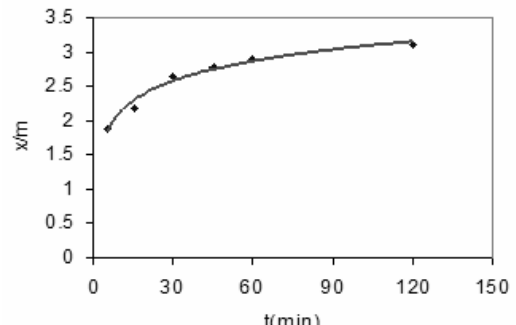
Figure 8 . Effect of exposure time on lead sorption or removal by SD and PANiEB/SD